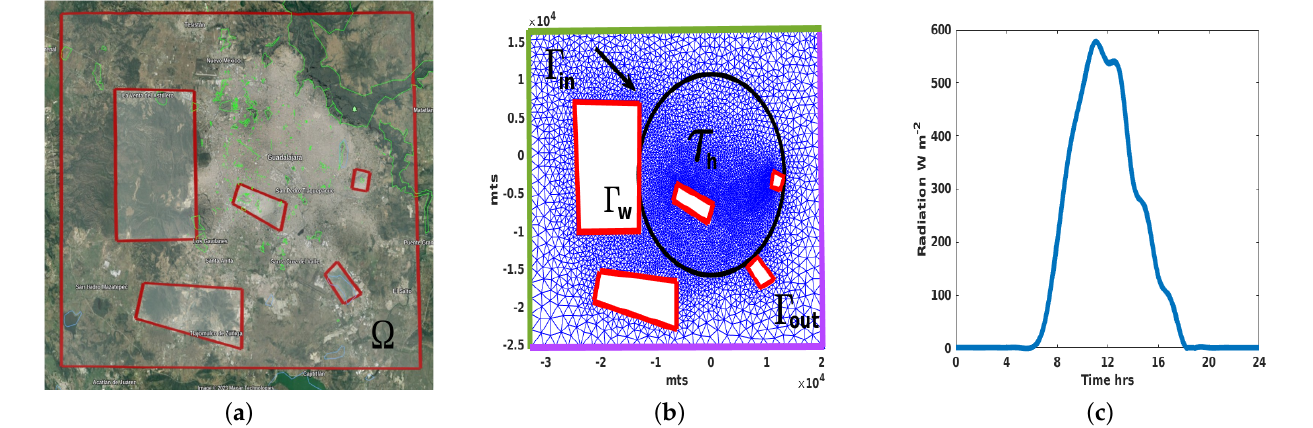
Figure 2. Study area idealization, mesh, and 24 h solar radiation. ( a ) Satellite photograph of the metropolitan region of Guadalajara with more of 40 km 2 (Google-Earth, 2023). Here, we denoted the boundaries and hills (idealized as rectangles) of the domain Ω with a red line. ( b ) Triangular mesh τ h , inlet boundary Γ in (green), outlet boundary Γ out (magenta), hills walls Γ w (red), and the urban-limit layout (black) as a circumference of radius r . The black arrow shows the inlet wind direction. ( c ) Typical global day-long solar radiation R s ( t ) with maximum values at midday and almost zero on either side.